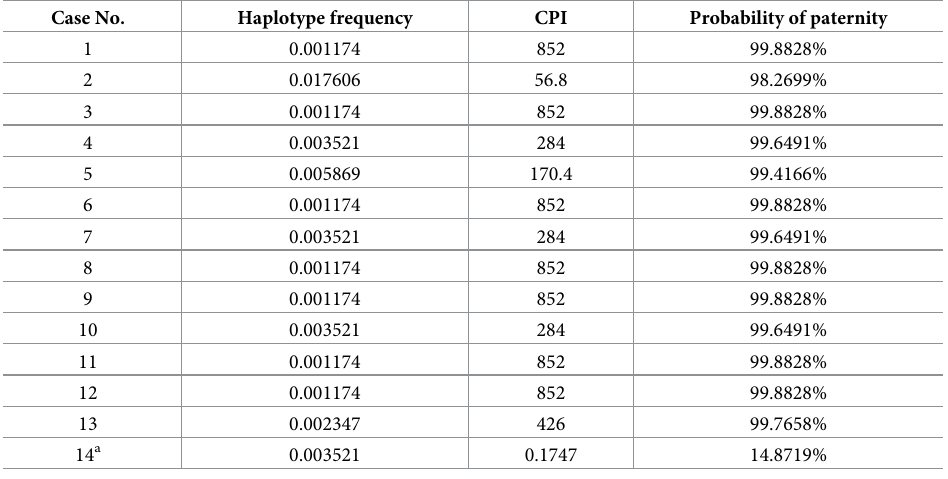
Table 1. The paternity testing parameters using cffDNA in the 14 cases with male fetuses. Case